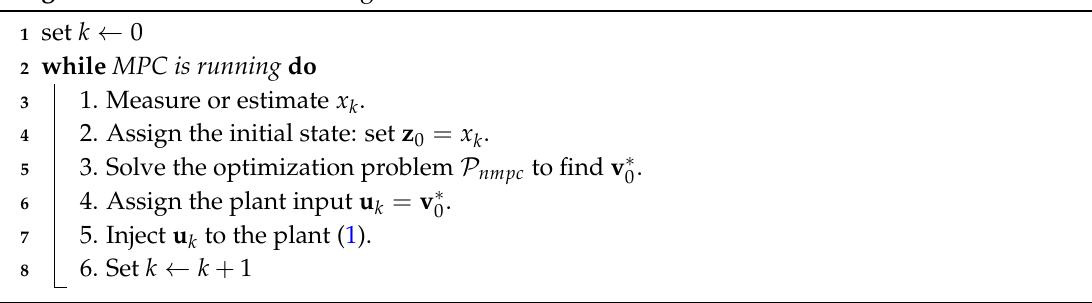
Algorithm 1: General NMPC